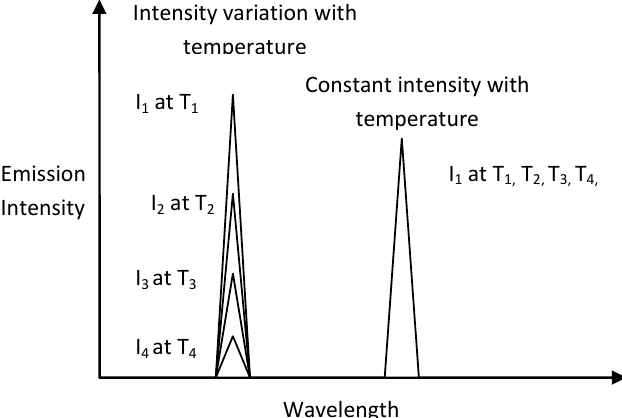
Figure 9. Ideal intensity variations for the intensity ratio